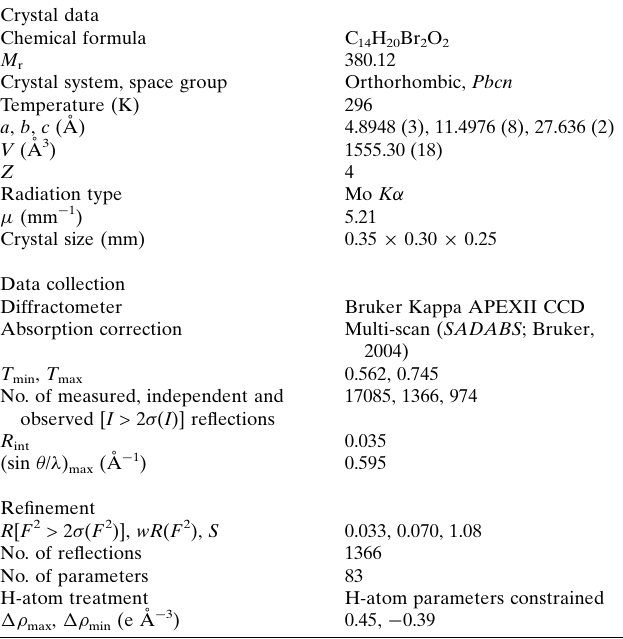
) that bisects atoms C5 and 2